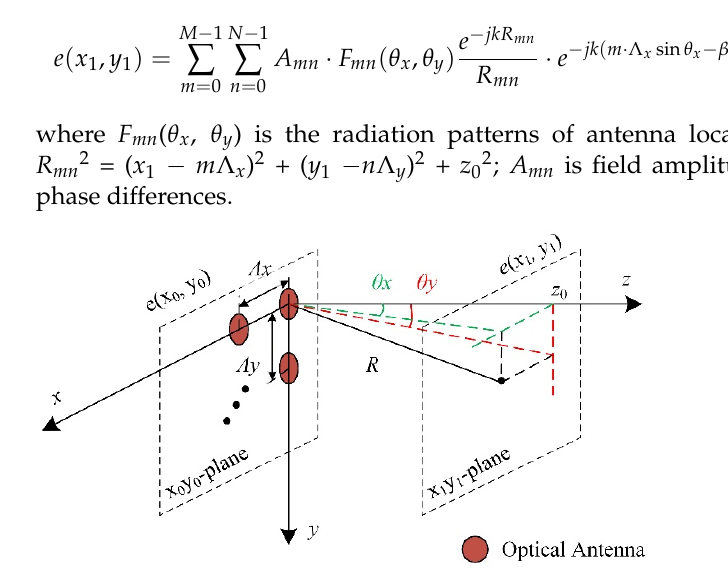
Figure 1. Schematic of the OPA.